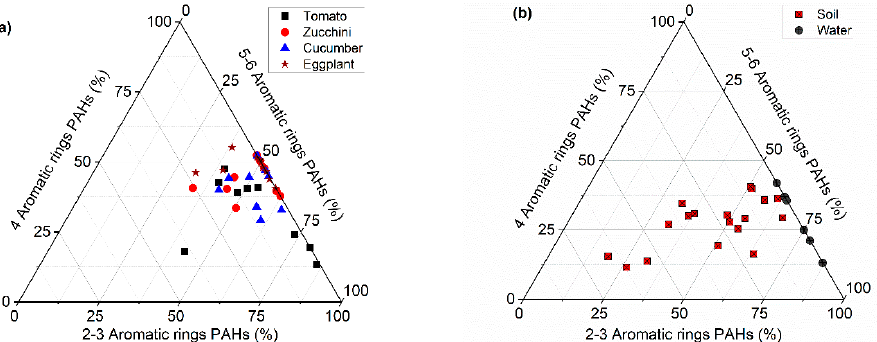
Figure 4. Ternary plot of PAH compositions in ( a ) vegetable samples and ( b ) water and soil samples.